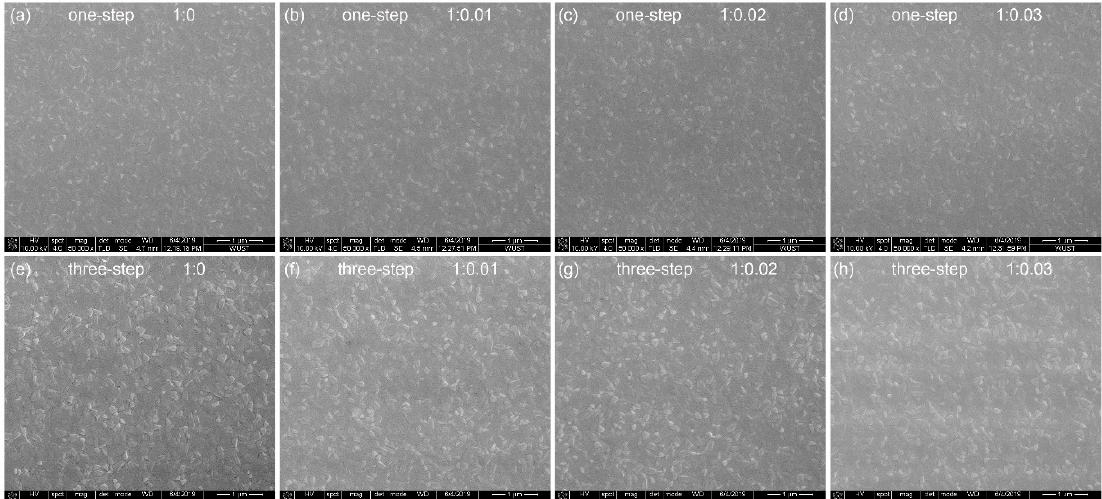
Figure 2. SEM images of the one-step spin-coated CH 3 NH 3 PbBr 3 film samples on ( a ) PEDOT:PSS, ( b ) PEDOT:PSS/MoO 3 -ammonia (1:0.01), ( c ) PEDOT:PSS/MoO 3 -ammonia (1:0.02), ( d ) PEDOT:PSS/MoO 3 -